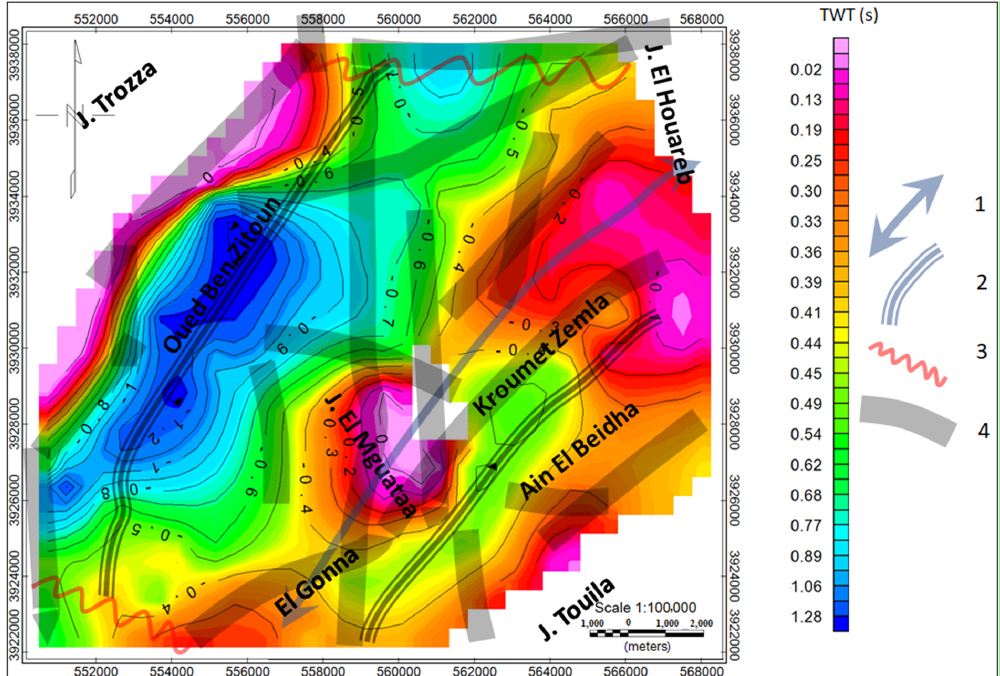
Figure 12. Isochron map of the top of the Oligocene aquifer. (1) Major positive gravity anomaly axis. (3) Major negative gravity anomaly axis. (4) Northern and southern limits of the Ain El Beidha plain. (4) Major fault/discontinuity corridors.